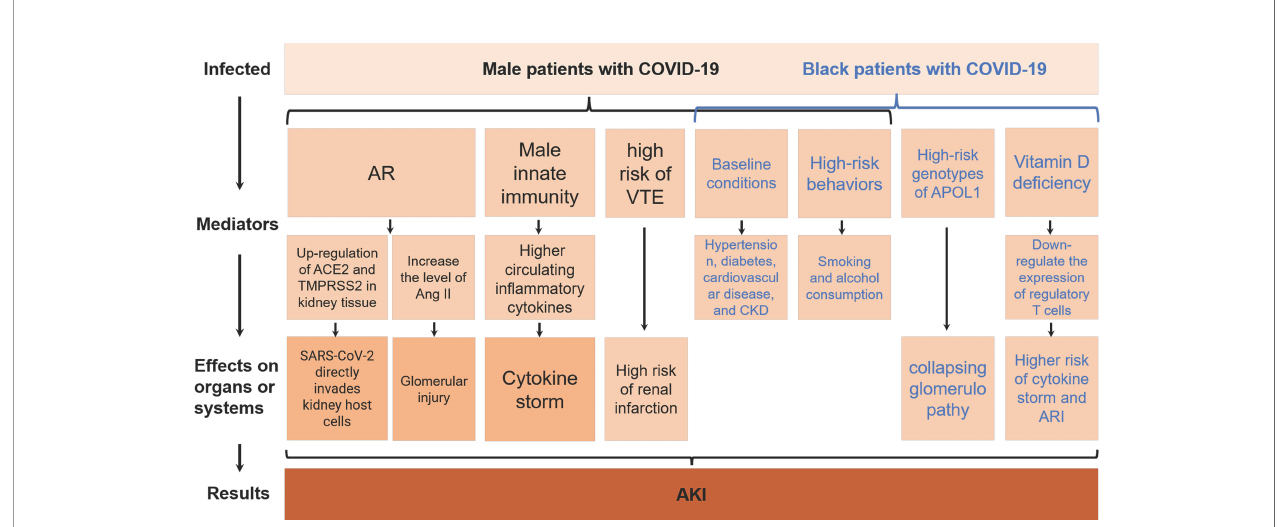
FIGURE 3 | AKI, acute kidney injury; AR, androgens; SARS-CoV-2, Severe Acute Respiratory Syndrome Coronavirus 2; COVID-19, coronavirus disease 2019; ACE2, angiotensin-converting enzyme 2; TMPRSS2, type II transmembrane serine protease; Ang II, angiotensin II; VTE, venous thromboembolism; CKD, chronic kidney disease; APOL1, apolipoprotein L1; ARI, acute respiratory